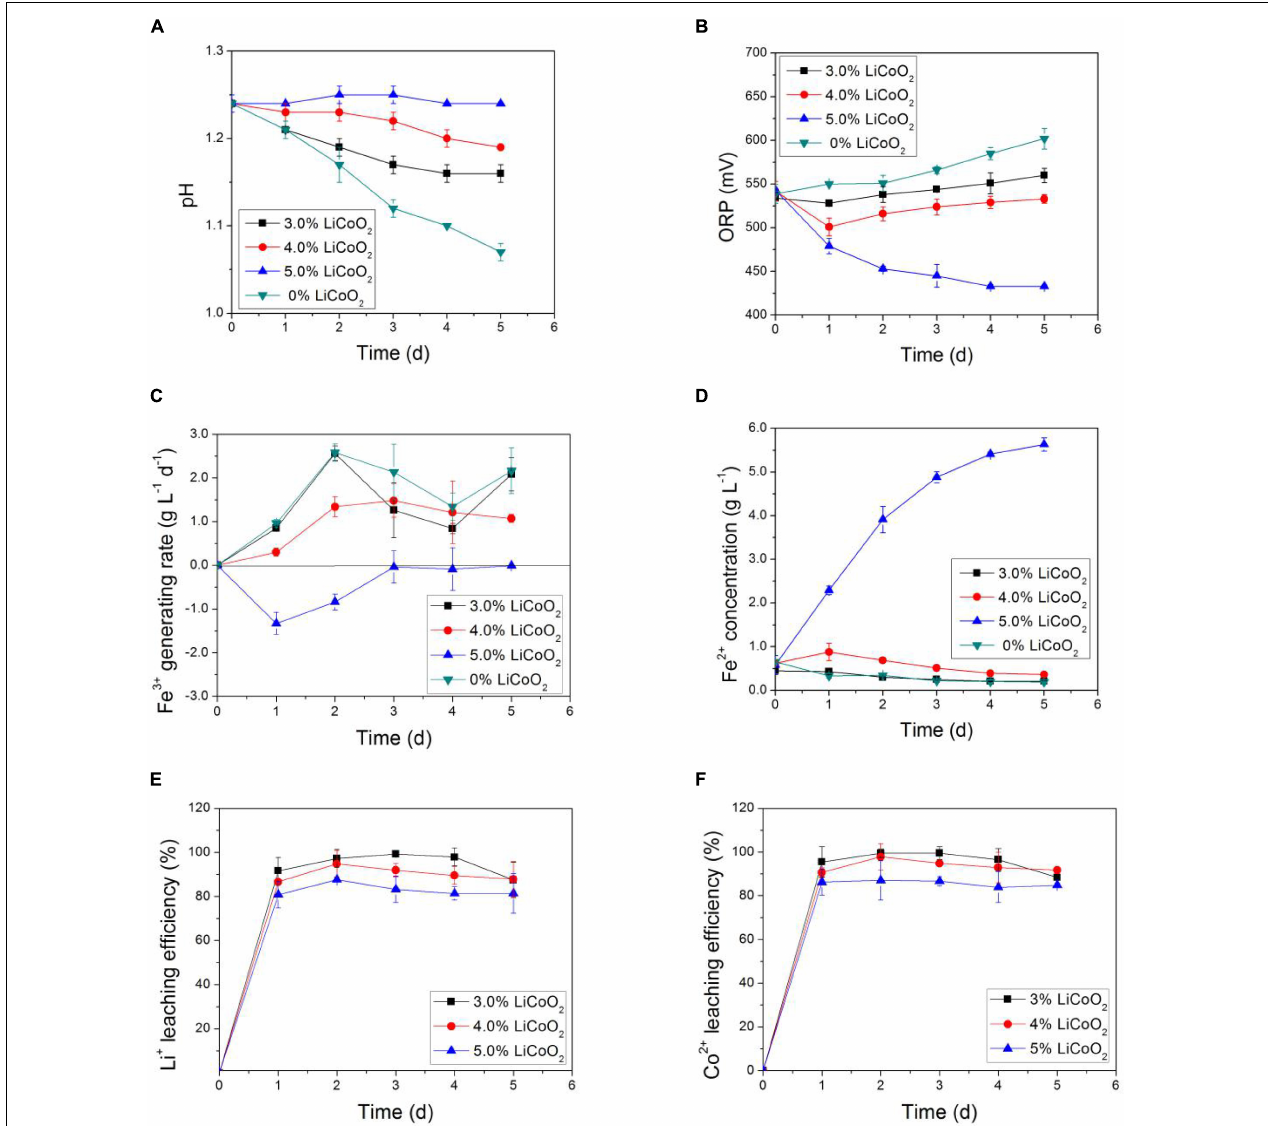
FIGURE 2 | Time-courses for (A) pH, (B) ORP, (C) Fe 3 + generation rate, (D) Fe 2 + concentration, (E) bioleaching efficiency of lithium, and (F) bioleaching efficiency of cobalt during bioleaching process of LiCoO 2 using the two-step method and the exogenous-acid adjustment